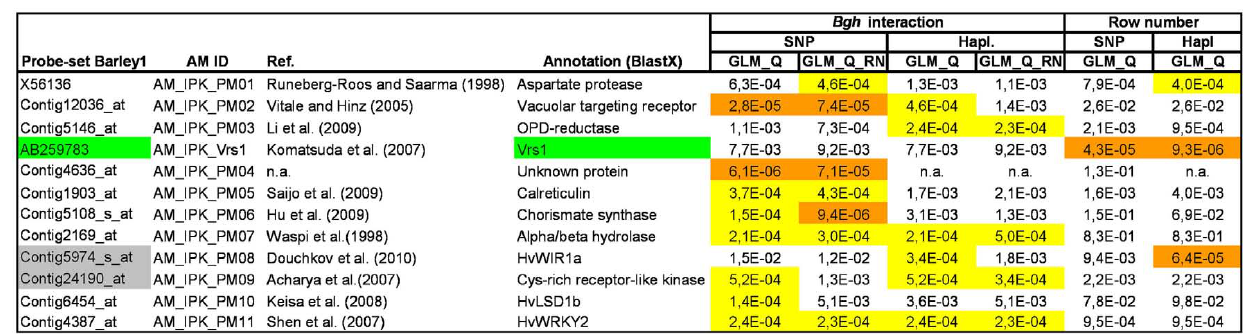
FIGURE 5 | Candidate genes significantly associated with resistance to Bgh . Association of SNP and gene haplotypes was calculated for traits “ Bgh interaction” and “row number” by using general-linear models that included population structure (Q-matrix, both traits) or population structure plus row number (RN) as covariate (only Bgh ).The Vrs1 gene (highlighted in green) was included as positive control for association with row number. Genes